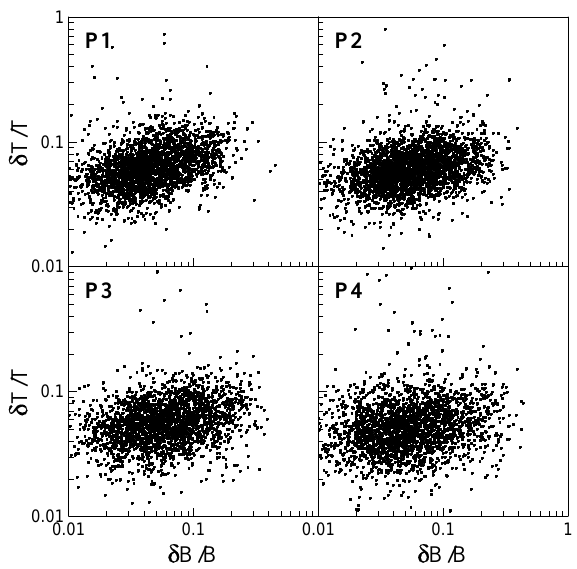
Fig. 11. Scatter plots of the relative amplitudes of temperature vs. magnetic field magnitude fluctuations for polar wind samples P1 to P4.